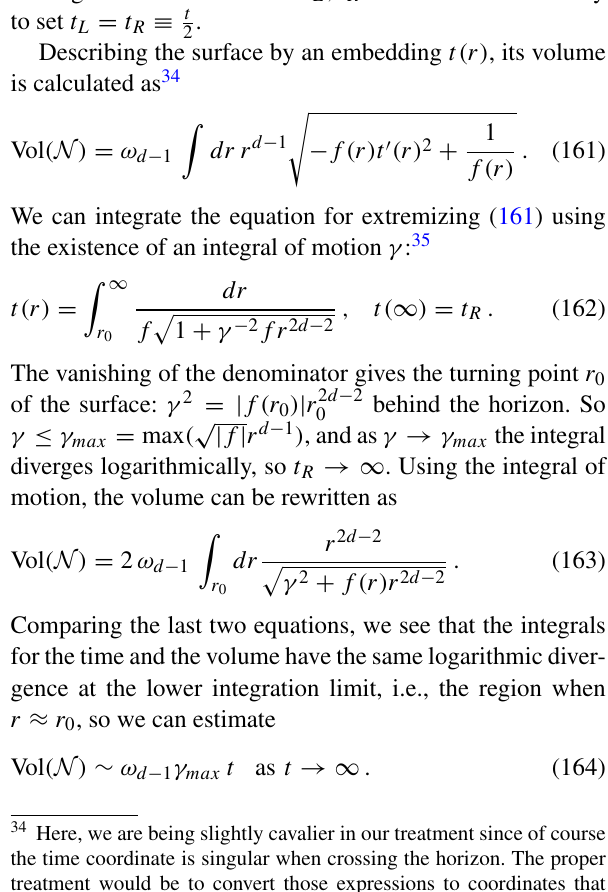
under the evolution generated by H L − H R . In Kruskal coor- dinates, the boundaries are located at UV = − 1, the horizon is the union of the lines U = 0 and V = 0, and the black hole singularity is at a constant value of UV >